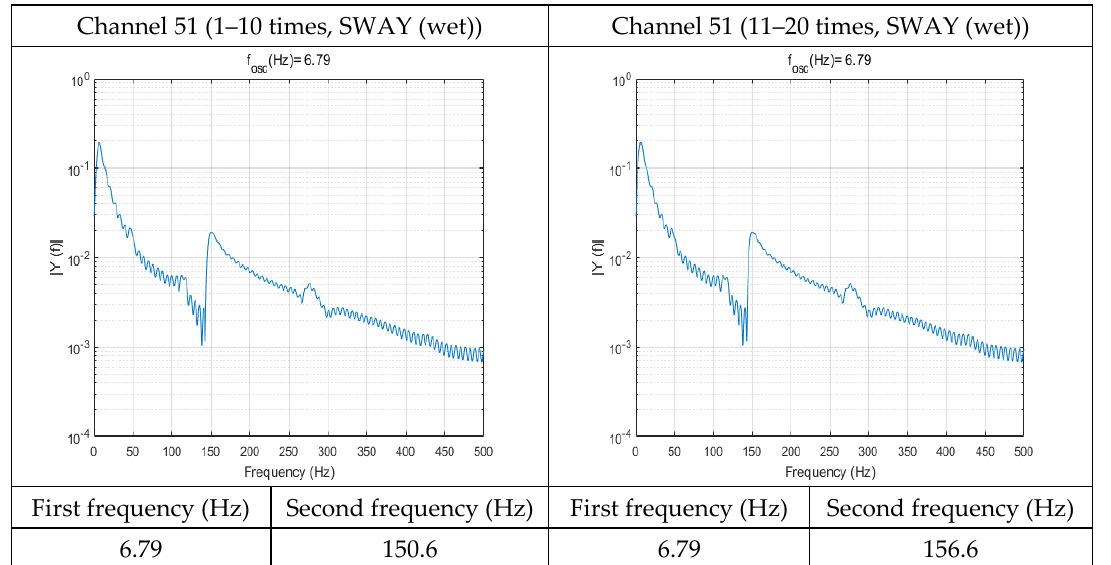
Figure 18. FFT of Channel 46 (Wet Condition, SWAY). J. Mar. Sci. Eng. 2019 , 7 , x FOR PEER REVIEW